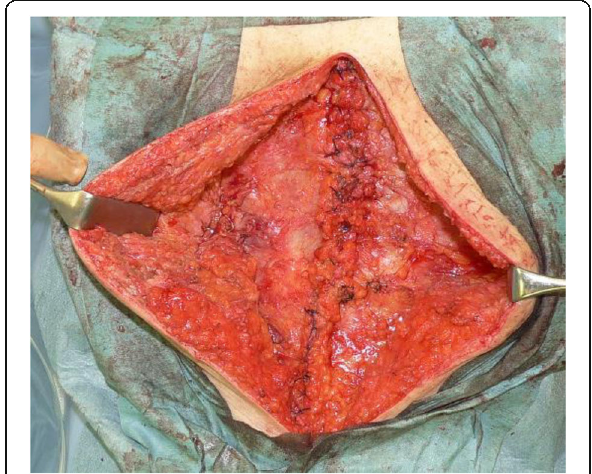
Fig. 5 Anterior rectus sheath closure